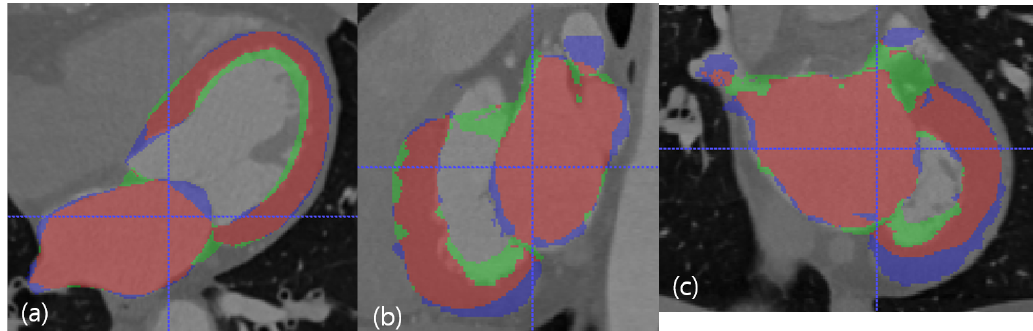
Figure 6. The median case in the dimension of DC. The red resultant mask is true positive, the blue mask is false negative, and the green resultant mask is false positive. SSD, HD, and DC are presented as the (LV SSD, LA SSD, LH SSD, LV HD, LA HD, DC) set, which is (1.79 mm, 2.16 mm, 1.98 mm,